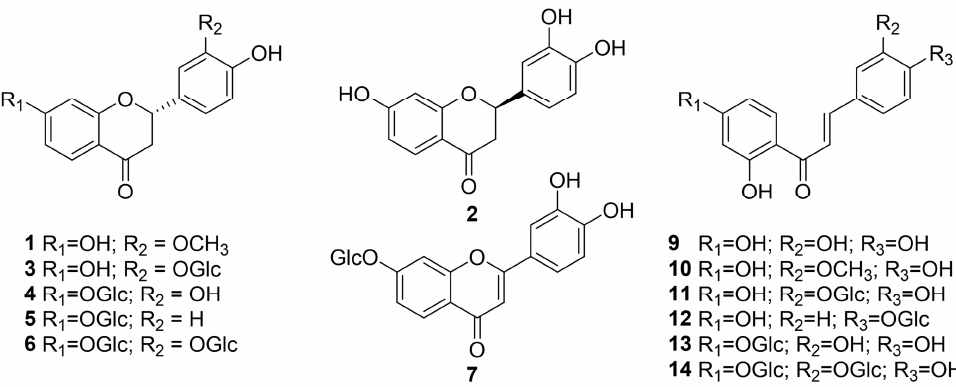
Figure 1. Chemical structures of compounds 1 – 14 isolated from Butea monosperma fl owers.